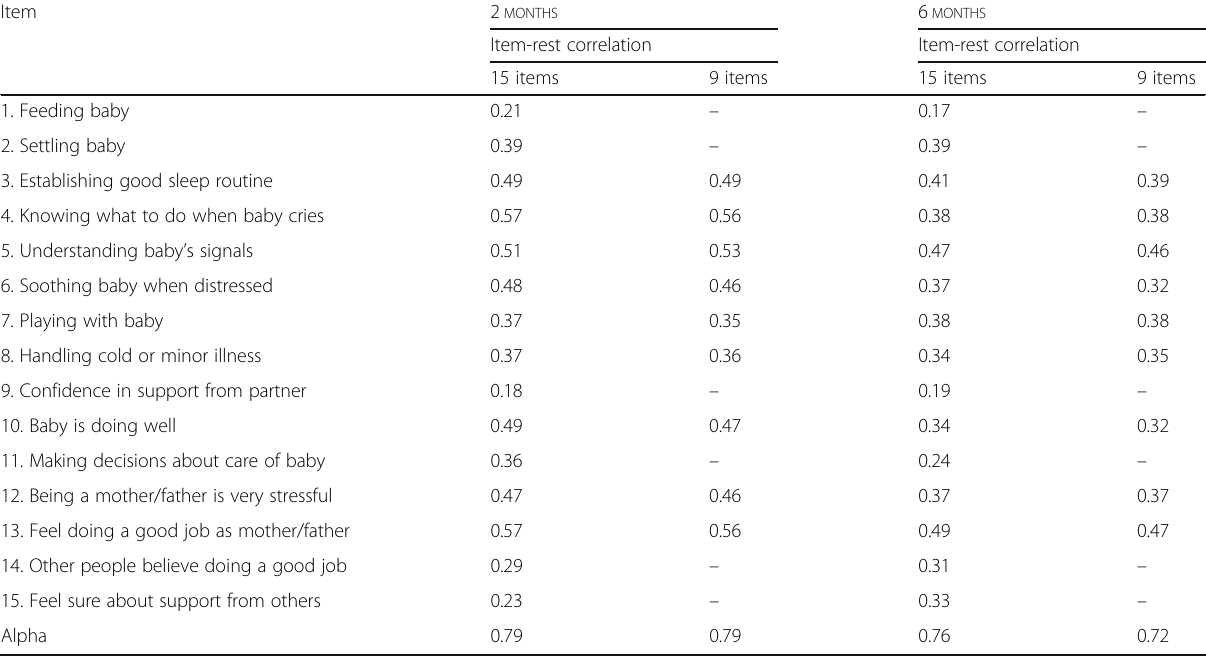
Table 4 Item-rest correlations and total Cronbach ’ s alpha for 15- and nine-item versions at two and six months